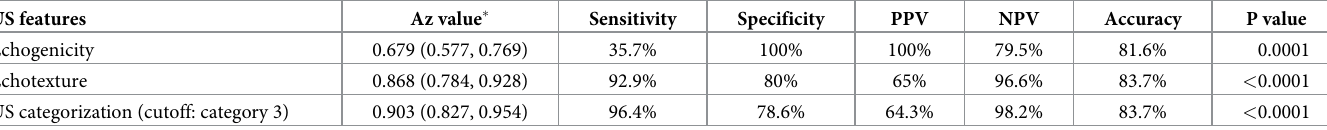
Table 2. Diagnostic performance of individual ultrasound features and ultrasound-based categorization for the detection of diffuse parotid disease in 98